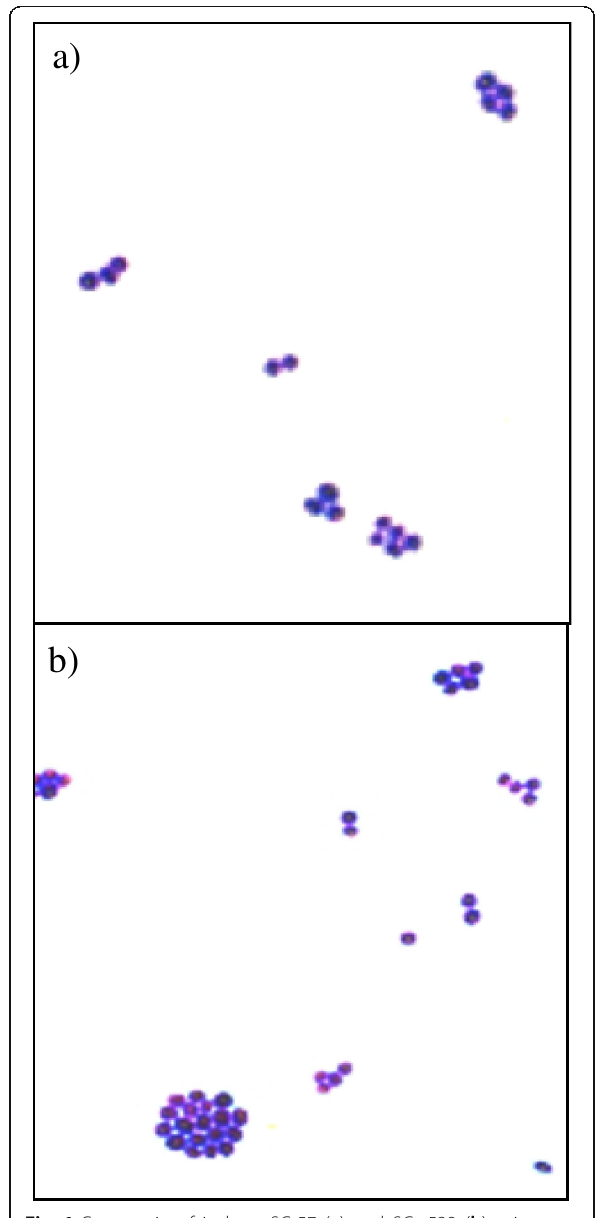
Fig. 1 Gram stain of isolates SC-57 ( a ) and SC -532 ( b ) using light microscopy at magnification